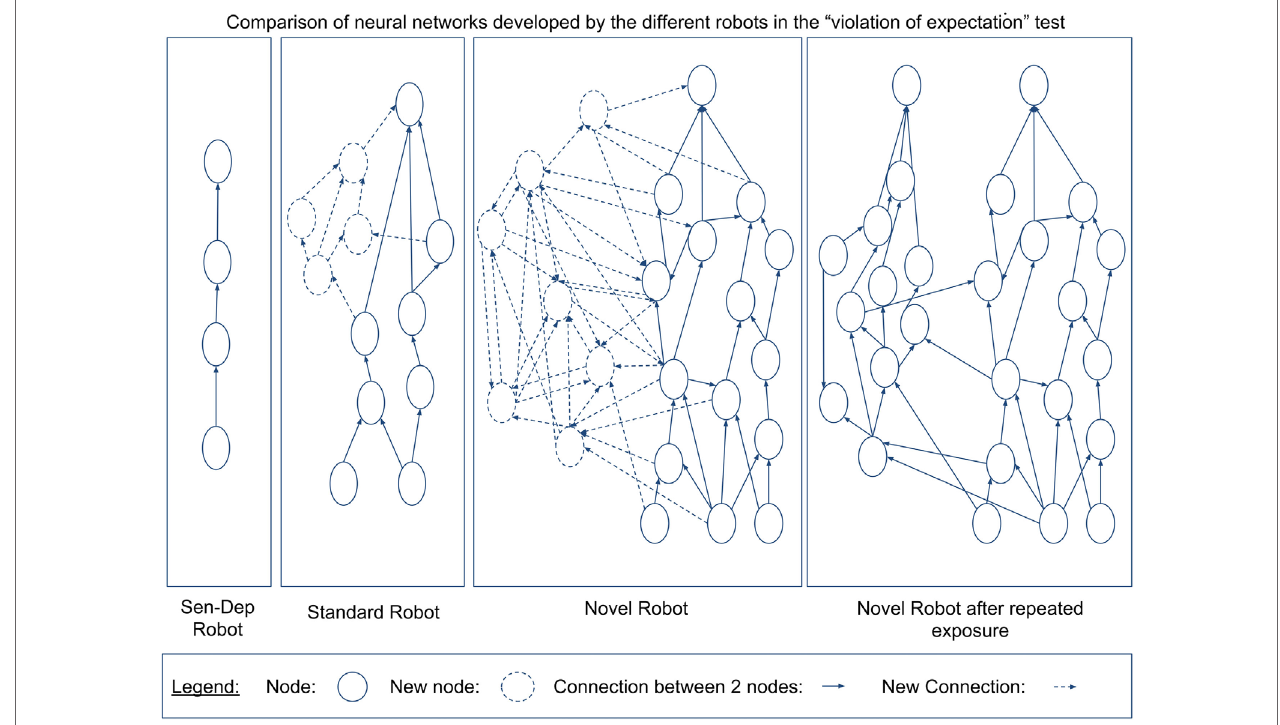
FigUre 13 | a snapshot of the neural pathway associated with a “violation of expectation episode . The greater effect can be seen in the network of the “Novel Robot”: exposure leads to the generation of a larger number of nodes and connections leading to a greater neural activity and to the creation of a new pathway if exposure to the same type of episode re-occurs often